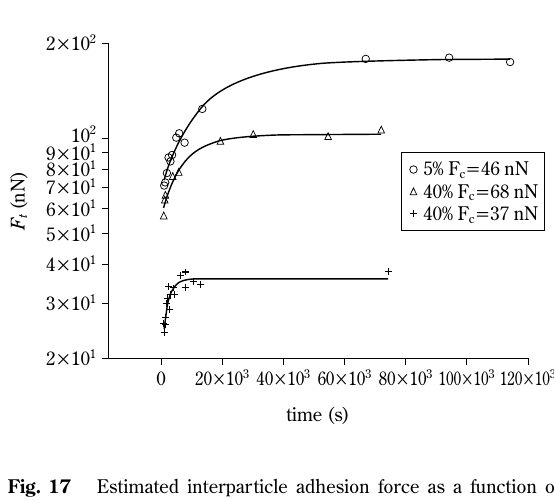
Estimated interparticle adhesion force as a function of the time during which the powder is consolidated. Exam- ples are shown for toner particles with different surface Aerosil coverage and subjected to different load